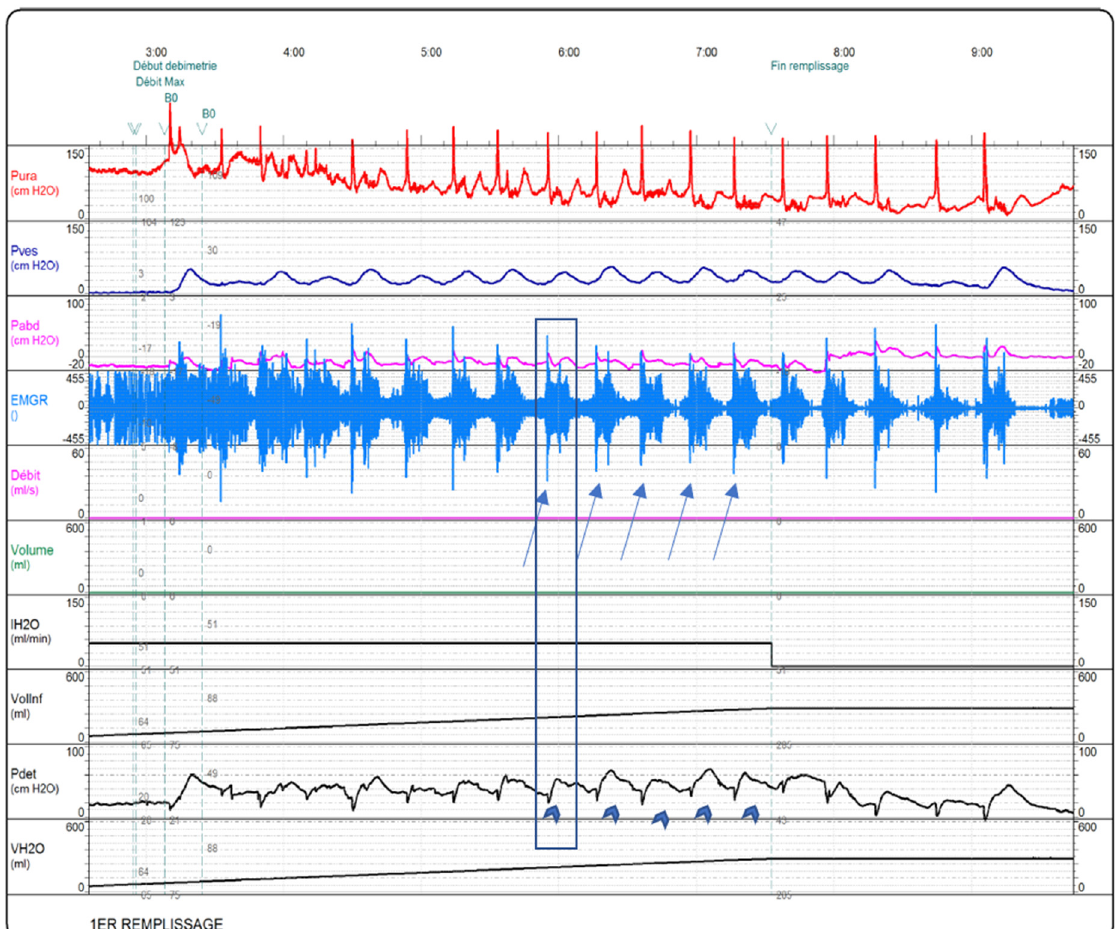
Figure 2. Urodynamics of type 2 (continuous) DSD according to ICS classification, where there is a continuous EUS contraction throughout the entire detrusor contraction. This case is better defined by type 2 according to the Blaivas et al. classification [5]: clonic EUS contractions in EMG channel (line arrows) and EUS pressure channel (red graph) interspersed through detrusor contractions (arrowheads), source: UdEPP Rehazenter database.